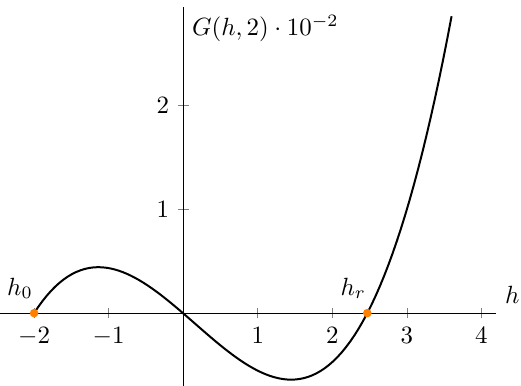
Figure 4. The G ( h; 2) function ( c = 48) where both the (cid:31) given by eq. (3.16). The crossing equation is inconsistent unless the weight h 1 of the (cid:12)rst excited state satis(cid:12)es h 1 < h r